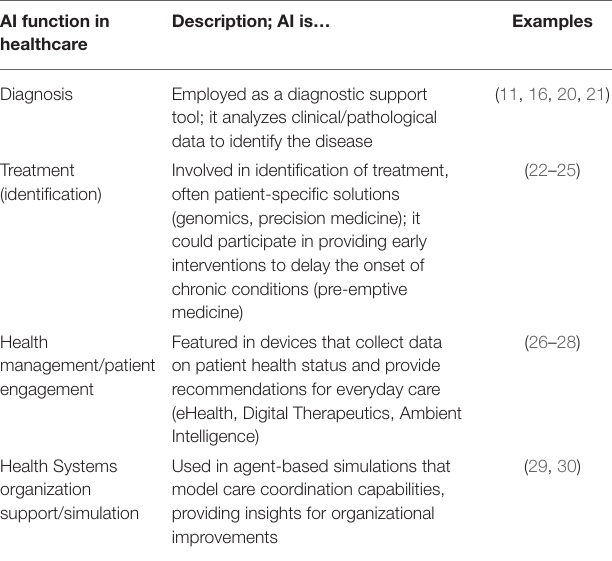
TABLE 1 | A resume of the main areas for AI implementation in healthcare and medicine. AI function in